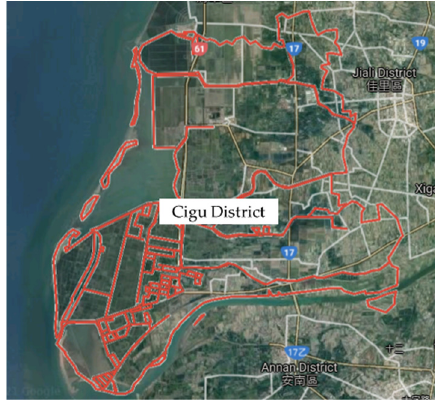
Figure 1. The area of Cigu District.